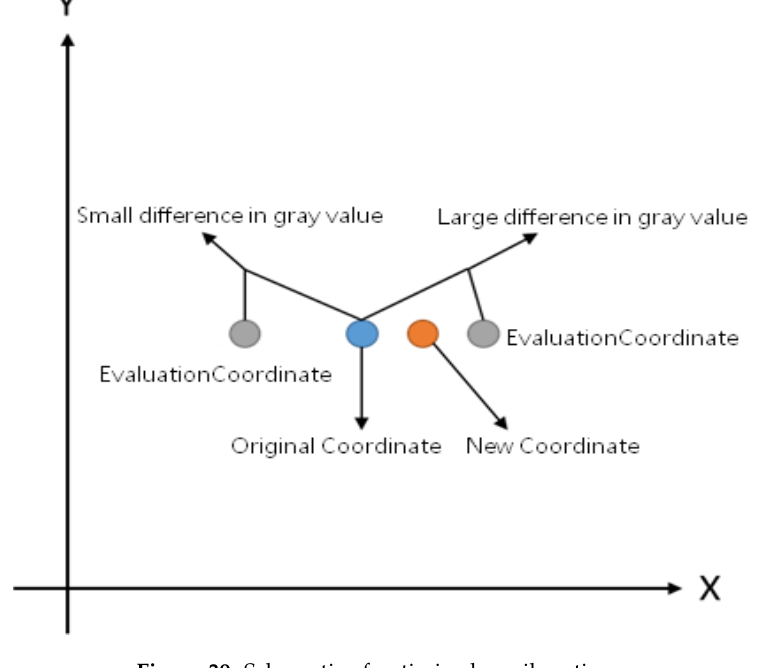
Figure 39. Schematic of optimized pupil vertices.